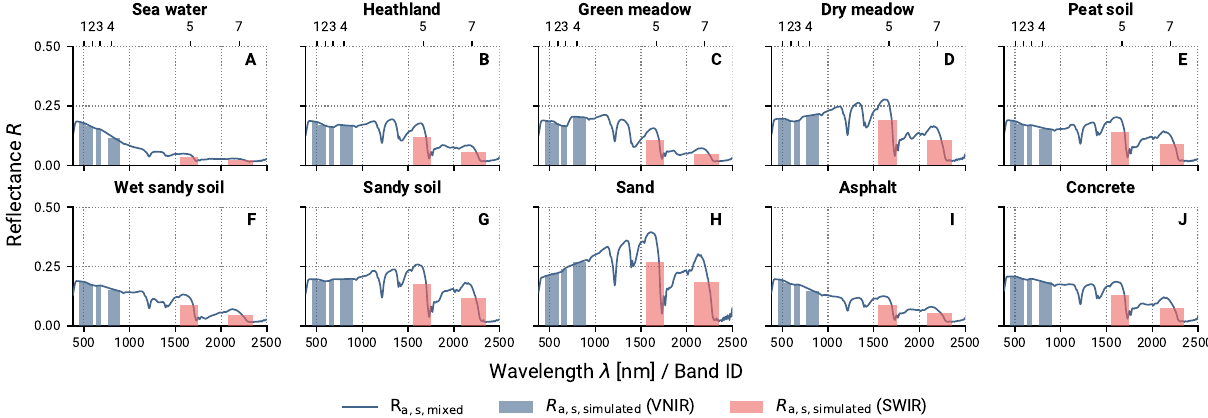
Figure 5. Simulated reflectance signals ( R a,s,simulated ) of PE-HD on selected background surfaces as for Landsat 5 TM/7 ETM+. ( A – J ) refer to the background surface spectra references given in Figure